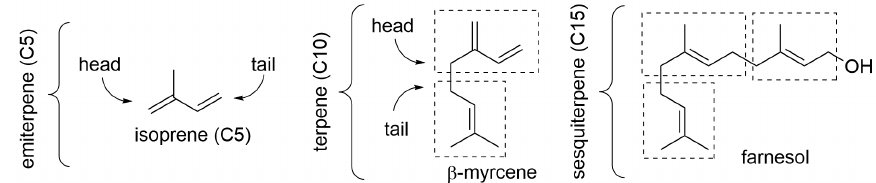
Figure 1. Structural features of volatile terpenes and terpenoids in essential oils.